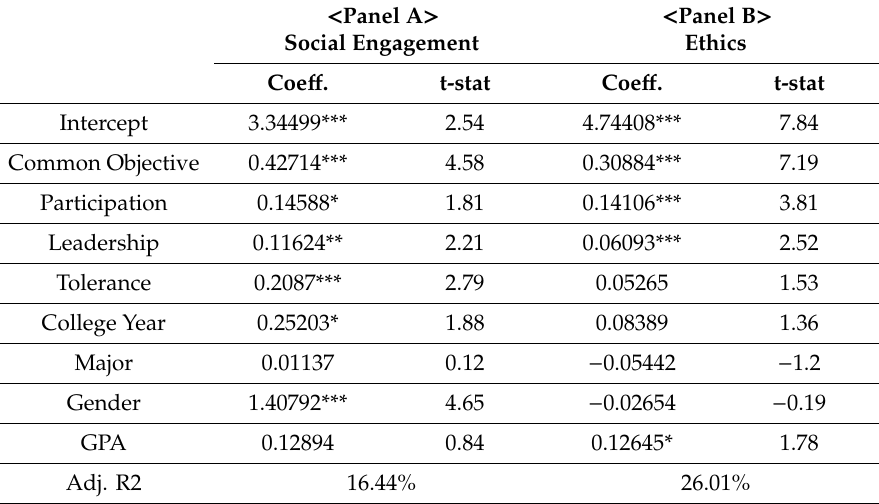
Table 5. E ff ects of Goal Setting on CSV.